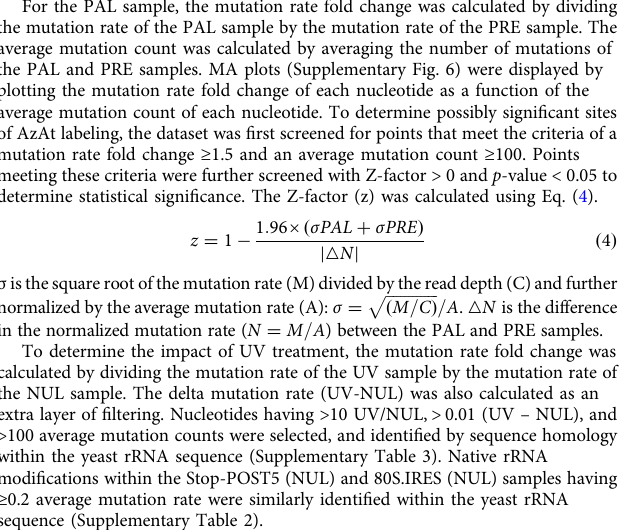
Fig. 4g,hwereindependentlyrepeatedbetween2 and 6 times(average3.3times) with error ranges determined as average deviations. The number of independent obser- vations for each curve in Fig. 4g, h varied between 16 –